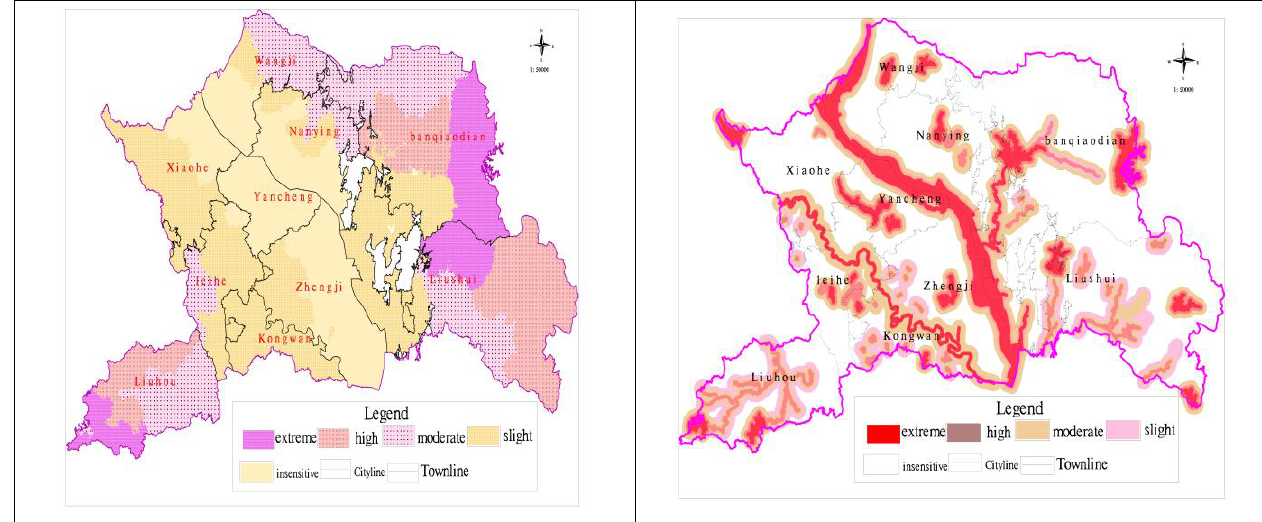
Figure 3. Sensitivity evaluation grade